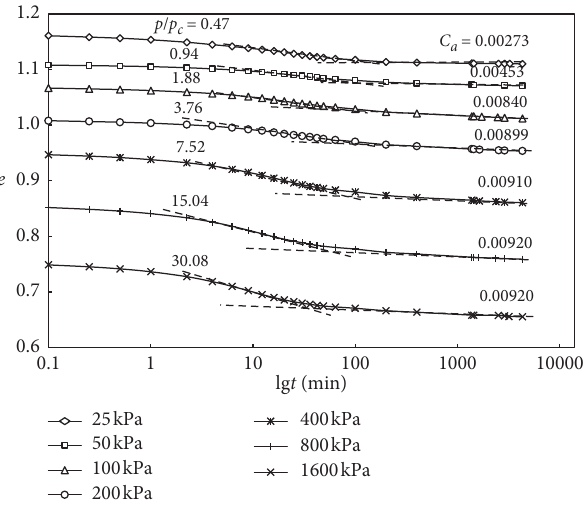
Figure 5: e − lg t curves under different consolidation pressures for the oedometer test (test no. 6).